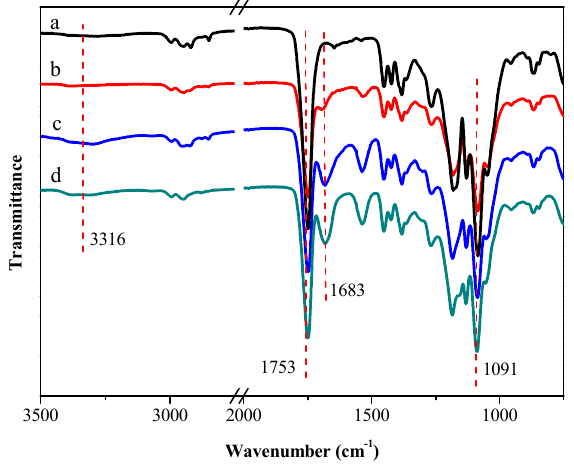
Figure 1. FT-IR spectra of PLGA and P(LA- co -GA- co -MMD) copolymers. ( a ) PLGA; ( b ) P(LA- co -GA- co -MMD) 1 ; ( c ) P(LA- co -GA- co -MMD) 2 ; and ( d ) P(LA- co -GA- co -MMD) 3 .